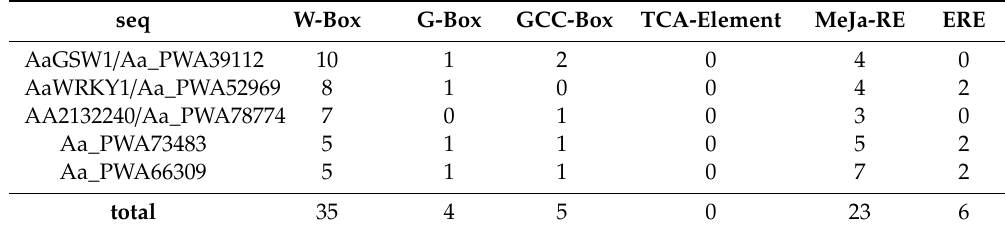
Table 2. RSAT analysis of the cis-regulatory elements in the promoters of selected WRKY genes. seq W-Box